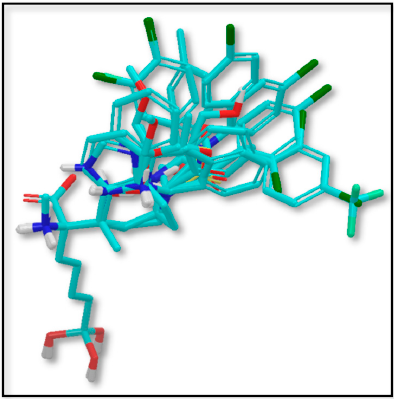
Figure 1. Dataset alignment for 3D-QSAR modeling.